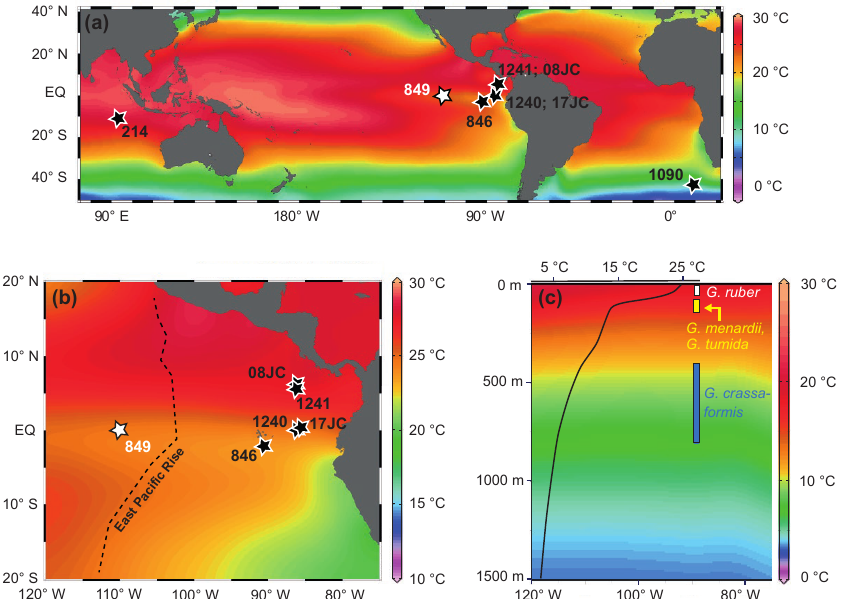
Figure 1. Location of the study area and present-day temperature profile at the study site. (a) Map indicating the location of the study site (ODP Site 849; white) and other sites mentioned in the text (black). (b) Map showing the location of Site 849 in the EEP “cold tongue” (white) and other east Pacific sites mentioned in the text (black). Colors in (a) and (b) denote mean annual surface-water temperatures. (c) Mean annual temperature profile for Site 849 showing the position of the thermocline. Calcification depths of foraminiferal species analyzed in this study are indicated by white ( G. ruber ), yellow ( G. menardii and G. tumida ) and blue ( G. crassaformis ) bars (because the calcification depth of G. crassaformis in the EEP remains unclear, we show its calcification depth range identified for the (sub-)tropical Atlantic and the Caribbean Sea; see Sect. 3 for details). Maps are from the World Ocean Atlas (Locarnini et al.,